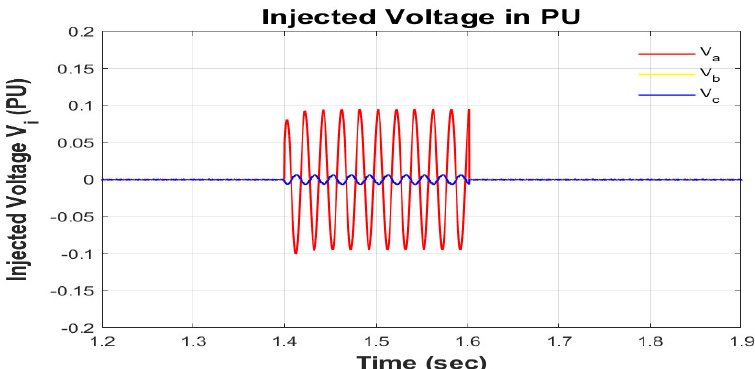
Figure 21. SFCL injected voltage at phase A during L − G fault.